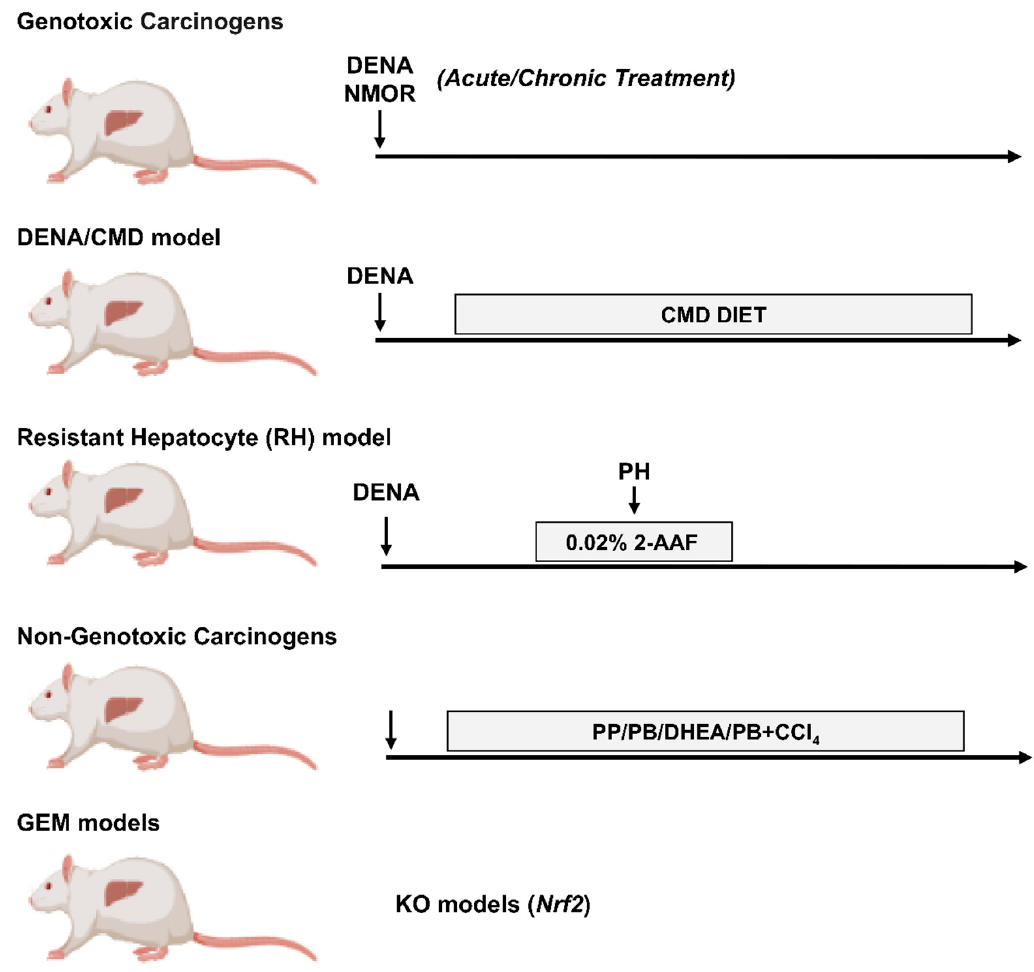
Figure 1. Examples of rat models used for the study of metabolic reprogramming in HCC. DENA: diethylnitrosamine; CMD: choline-devoid methionine-deficient diet; PH: partial hepatectomy; 2-AAF: 2-acetylaminofluorene; PP: Peroxisome Proliferator; PB: Phenobarbital; DHEA: dehydroepiandrosterone; CCl 4 : carbon tetrachloride; KO: knockout; Nrf2: nuclear factor, erythroid 2 like 2. The figure has been prepared by adapting BioRender images.